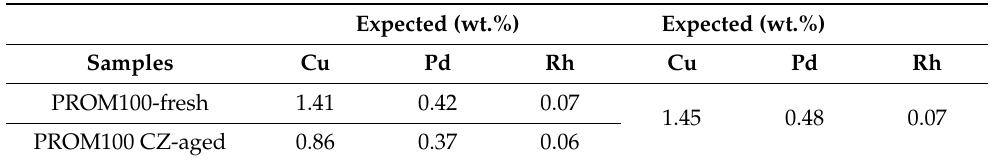
Table 1. Measured and theoretically expected copper and PGM loading of the synthesized powders (fresh and aged samples). Expected (wt.%) Expected (wt.%) Samples Cu